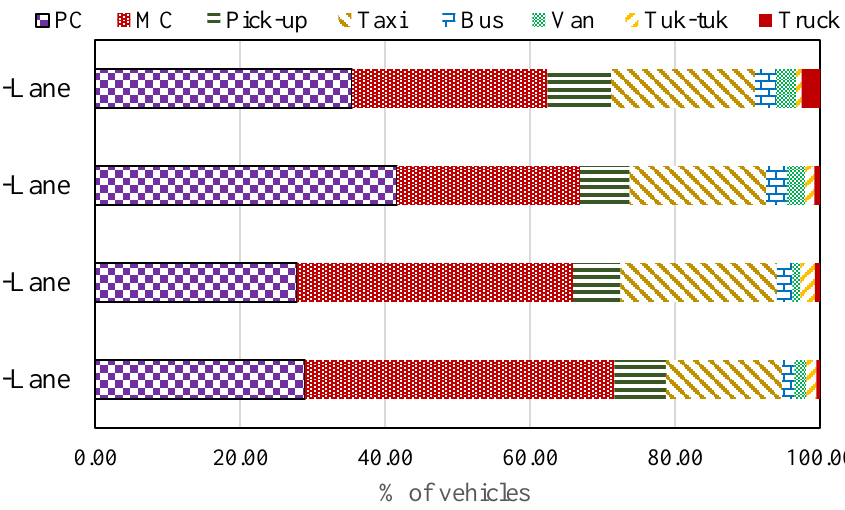
Figure 3. Proportion of different vehicle types on roads with different number of lanes in Bangkok.